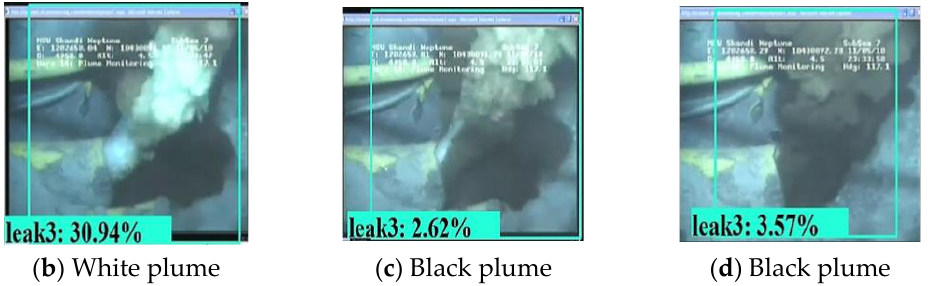
Figure 21. Visualization examples of the YOLOv4 model developed by the image size 480 × 480 dataset under the BP dataset.